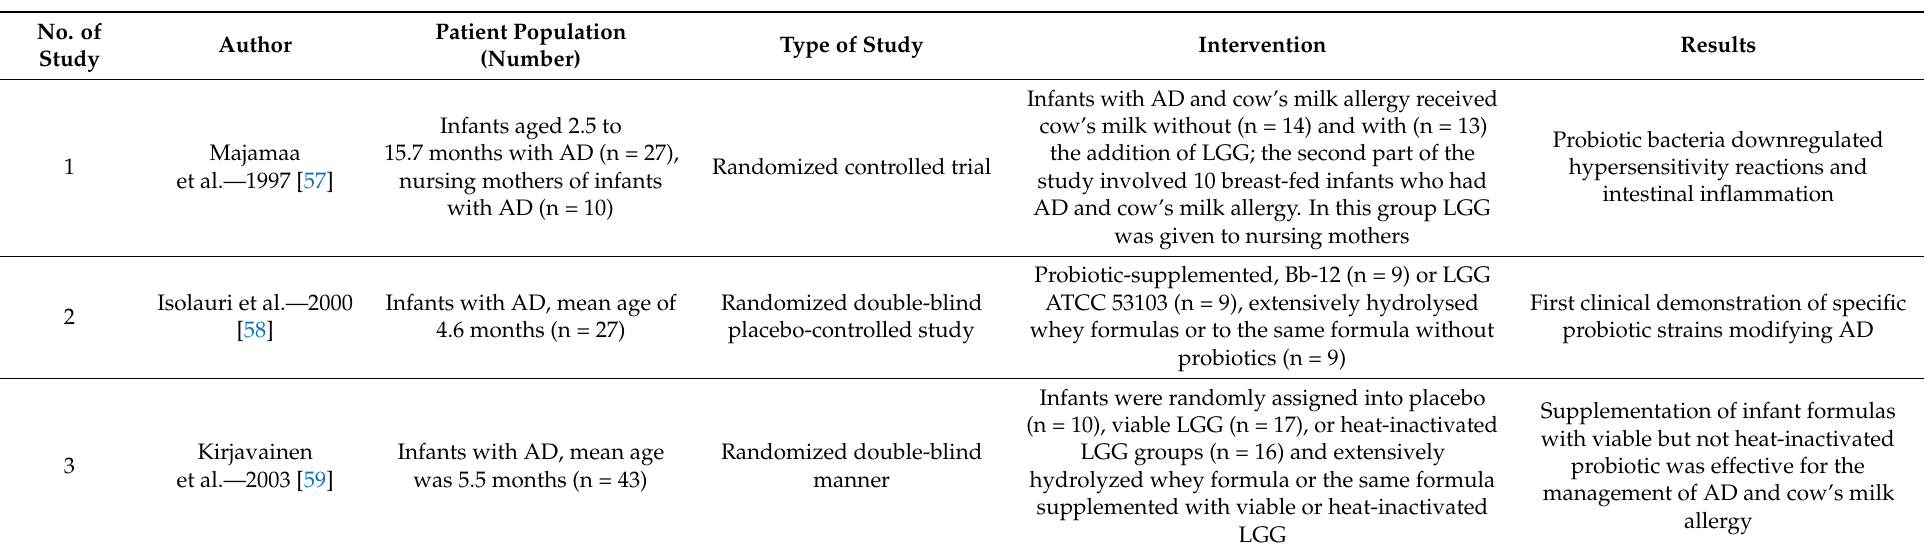
Table 3. Pre- and probiotics in the treatment of AD in